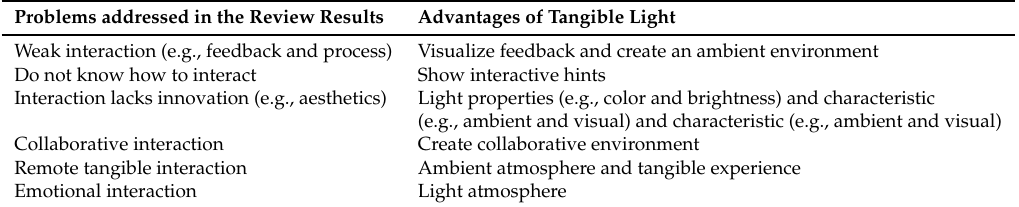
Table 9. Problems addressed by tangible